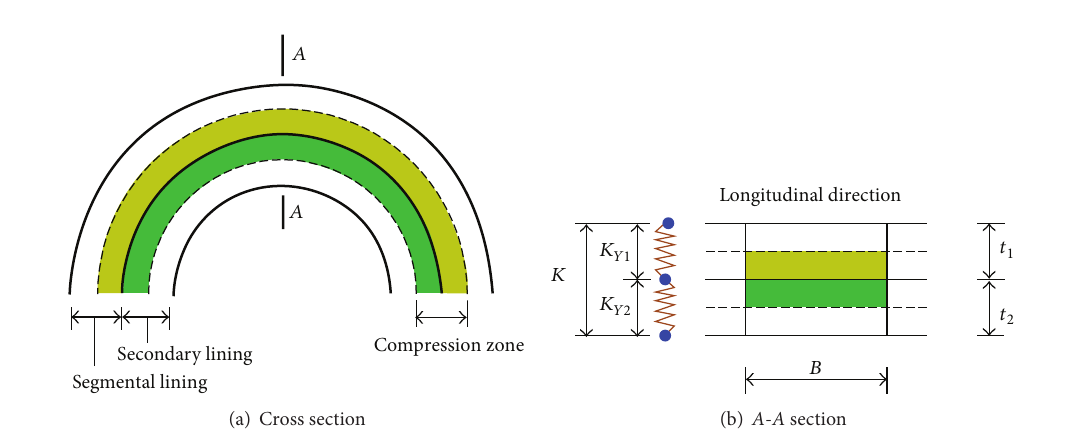
Figure 4: Compression stiffness calculation schematic diagram of junction